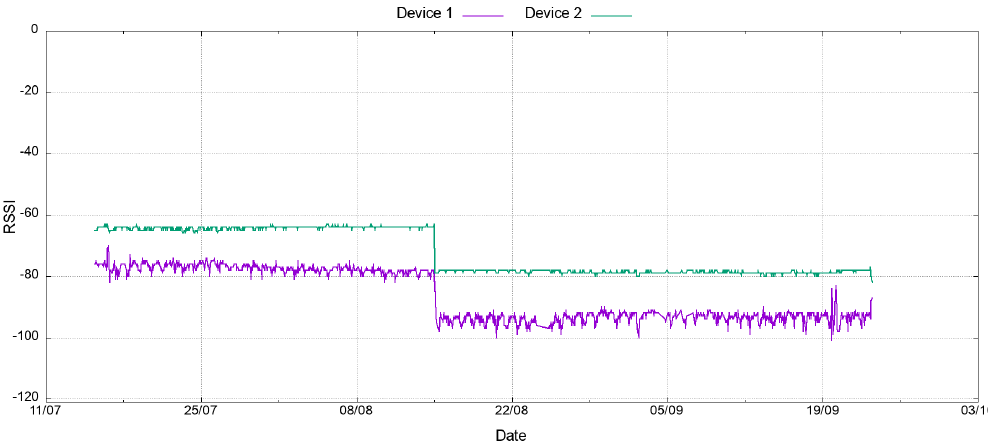
Figure 6. wM-Bus smart meter devices with sudden RSSI drop (Location 2).